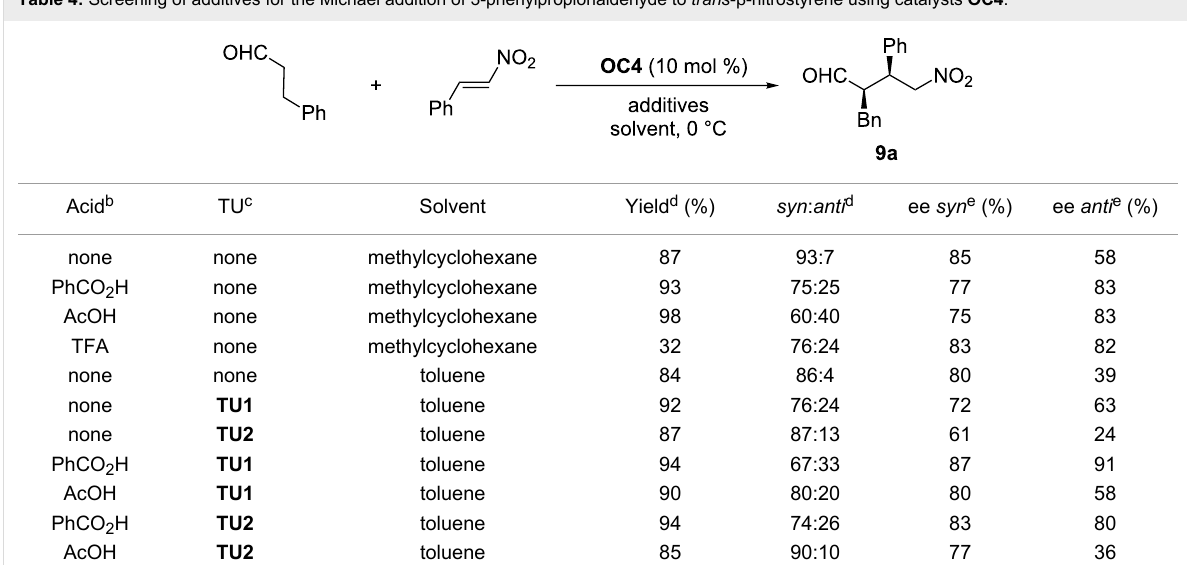
Table 4: Screening of additives for the Michael addition of 3-phenylpropionaldehyde to trans - β -nitrostyrene using catalysts OC4 . a